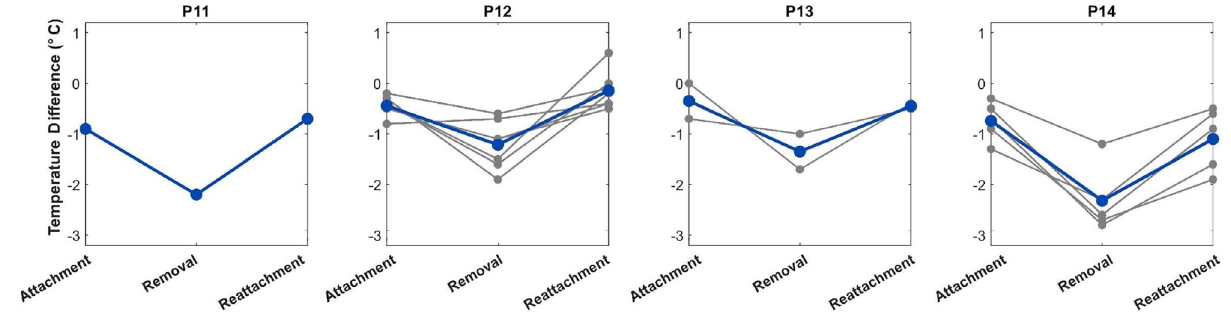
Figure 2. Changes in temperature asymmetry: Neuromusculoskeletal prosthesis-users show a smaller temperature difference between the residual and contralateral limbs when wearing their prostheses. For each participant, the grey lines indicate measurements of all image sets; the blue line indicates the average of all image sets.